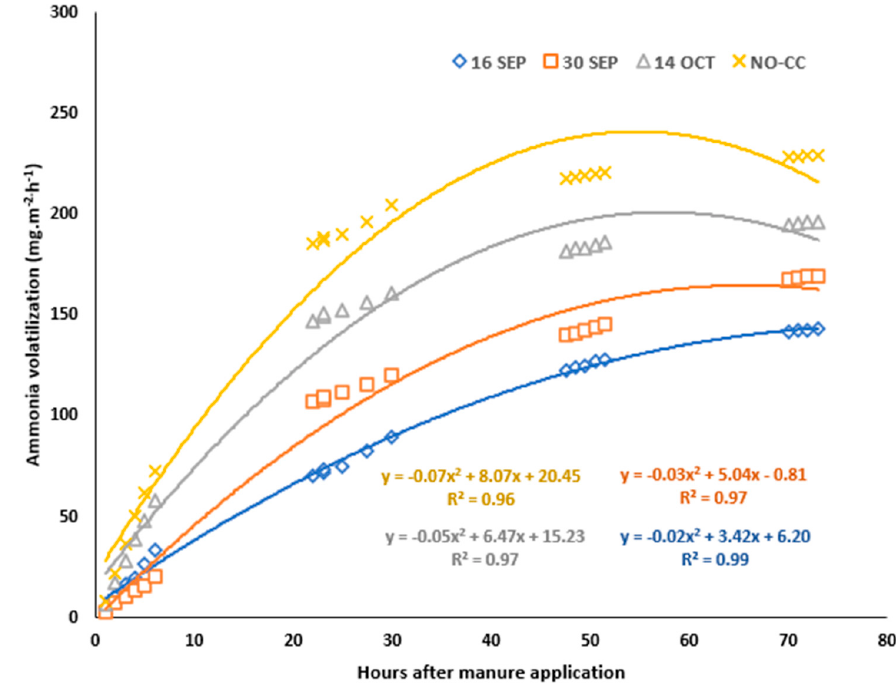
Figure 3. Ammonia volatilization as a function of time after manure application to the bare soil (no cover crop) and to the cover crops planted at different dates. SEP, OCT, and NO-CC are September, October, and No cover crop, respectively.